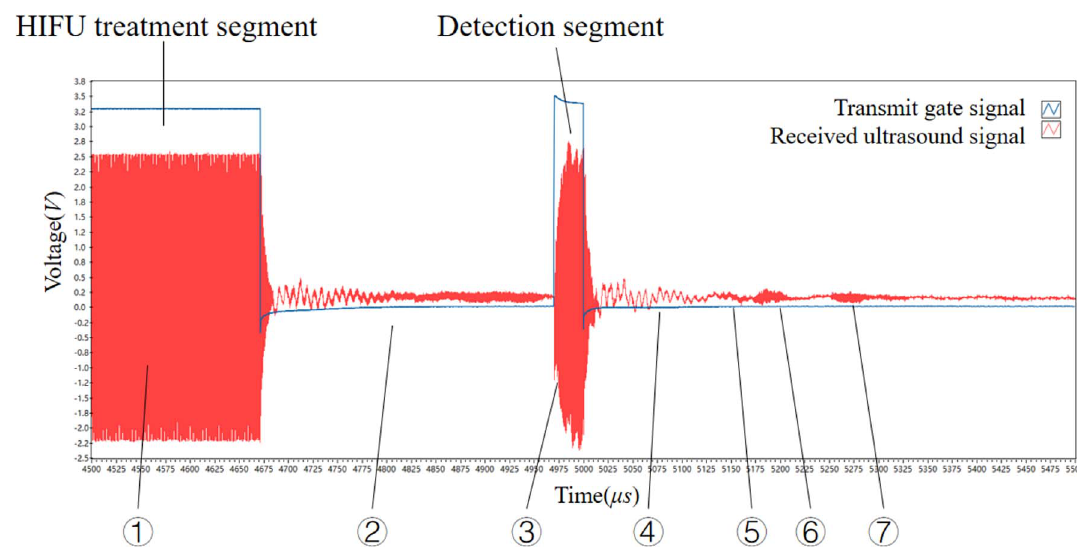
Figure 5. Re fl ected and scattered echo waveform (frame No. 25 in 125W20s